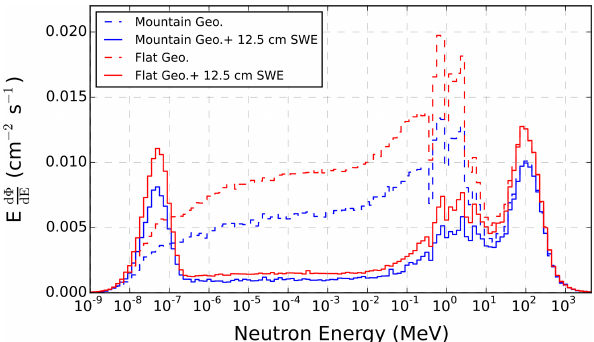
Figure 2. Neutron flux spectra for horizontal (red) and slanted soil (blue), with 50cm snow layer (corresponding to 12.5cm SWE) (solid line) and without snow (dashed line).